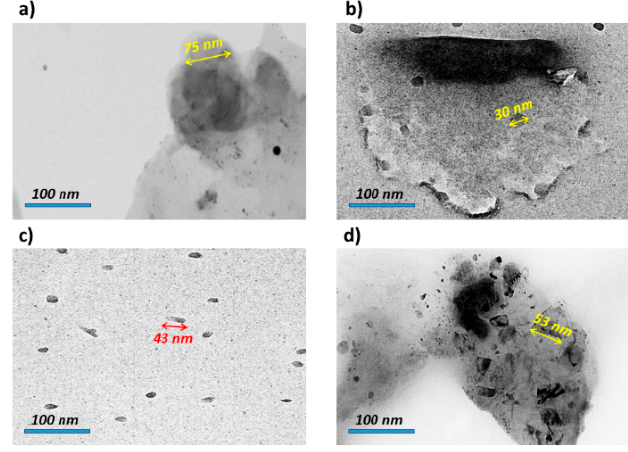
Figure 6. TEM images of ( a ) Alloy, ( b ) C1, ( c ) C2 and ( d ) C3.